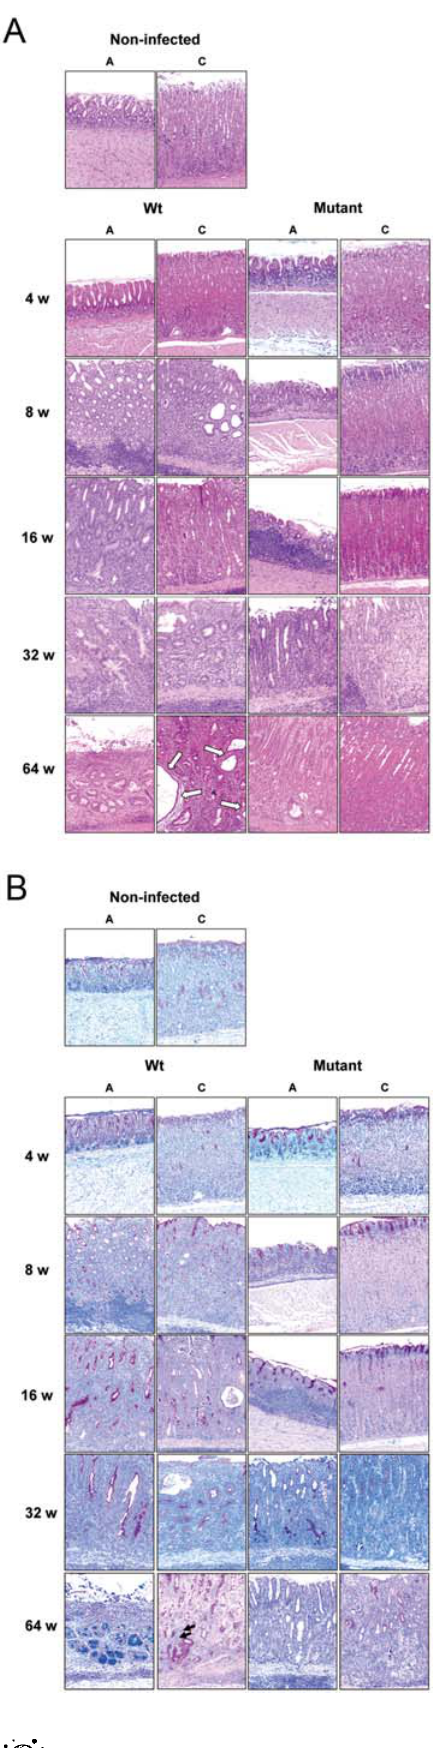
Figure 3. Increased severity of inflammation in H.pylori B128 WT infected gerbils. (A) H&E and (B) alcian blue-PAS stained paraffin- embedded antral [A] and corpus [C] tissue (original magnification 6 10). Mucous gland metaplasia (black arrows) and gastritis cystica profunda (white arrows) are shown. Gerbils were orally challenged with H. pylori B128 WT (left panels) and B128 D cag Y isogenic mutant strain (right panels) for 2, 4, 8, 16, 32 and 64 weeks [w].